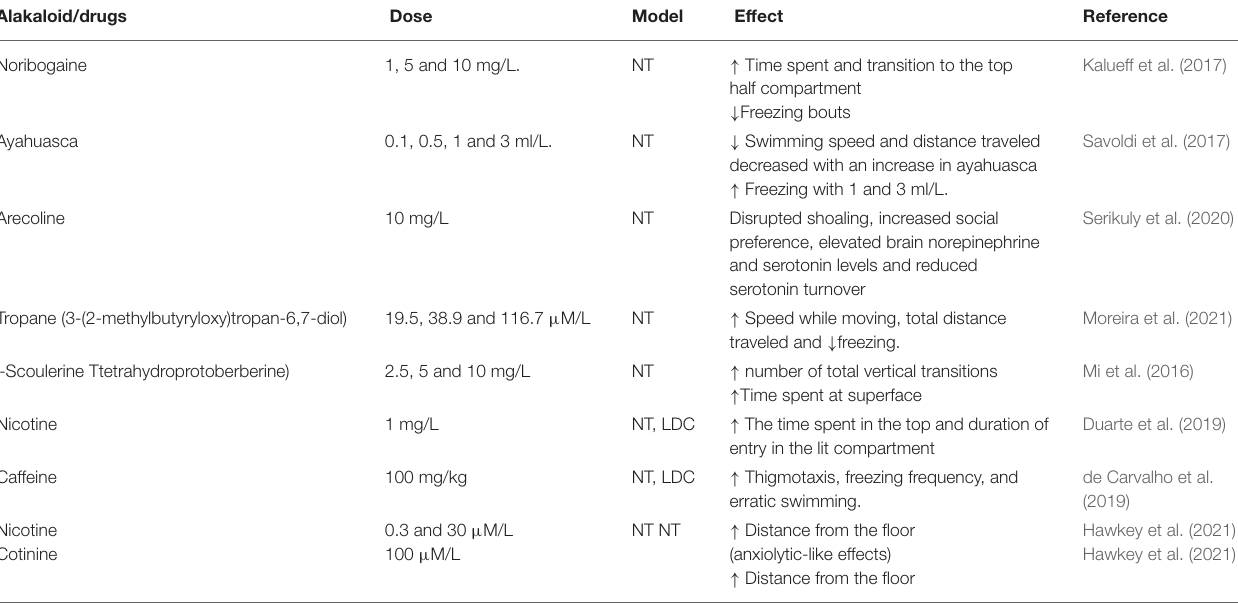
TABLE 3 | Behavioral effects of Alkaloid and drugs of abuse in adult zebrafish. Alakaloid/drugs Dose Model